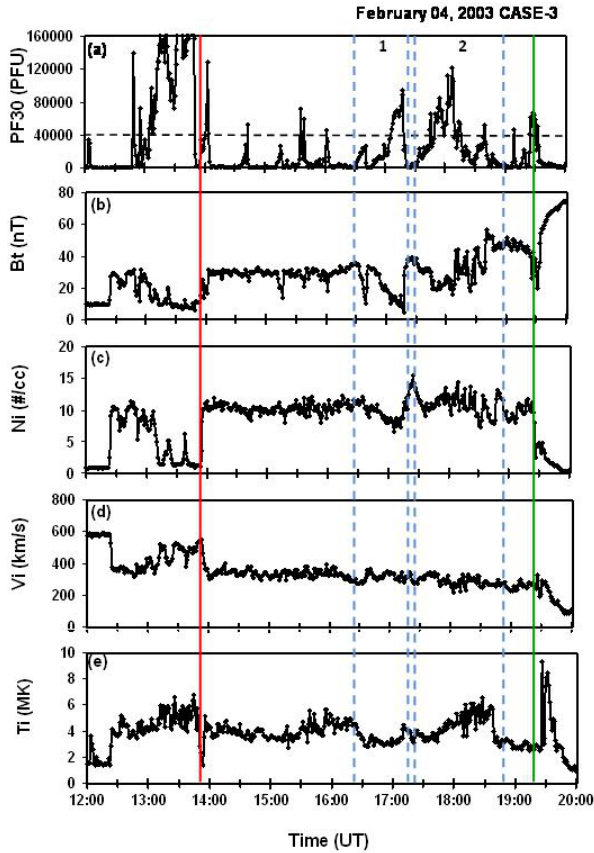
Fig. 14. Plots of particle flux (PF30), magnetosheath magnetic field strength, density, speed, and temperature data versus time for 4 February 2003 (from top to bottom). Red and green lines show bow shock and magnetopause while blue lines indicate the burst events studied.